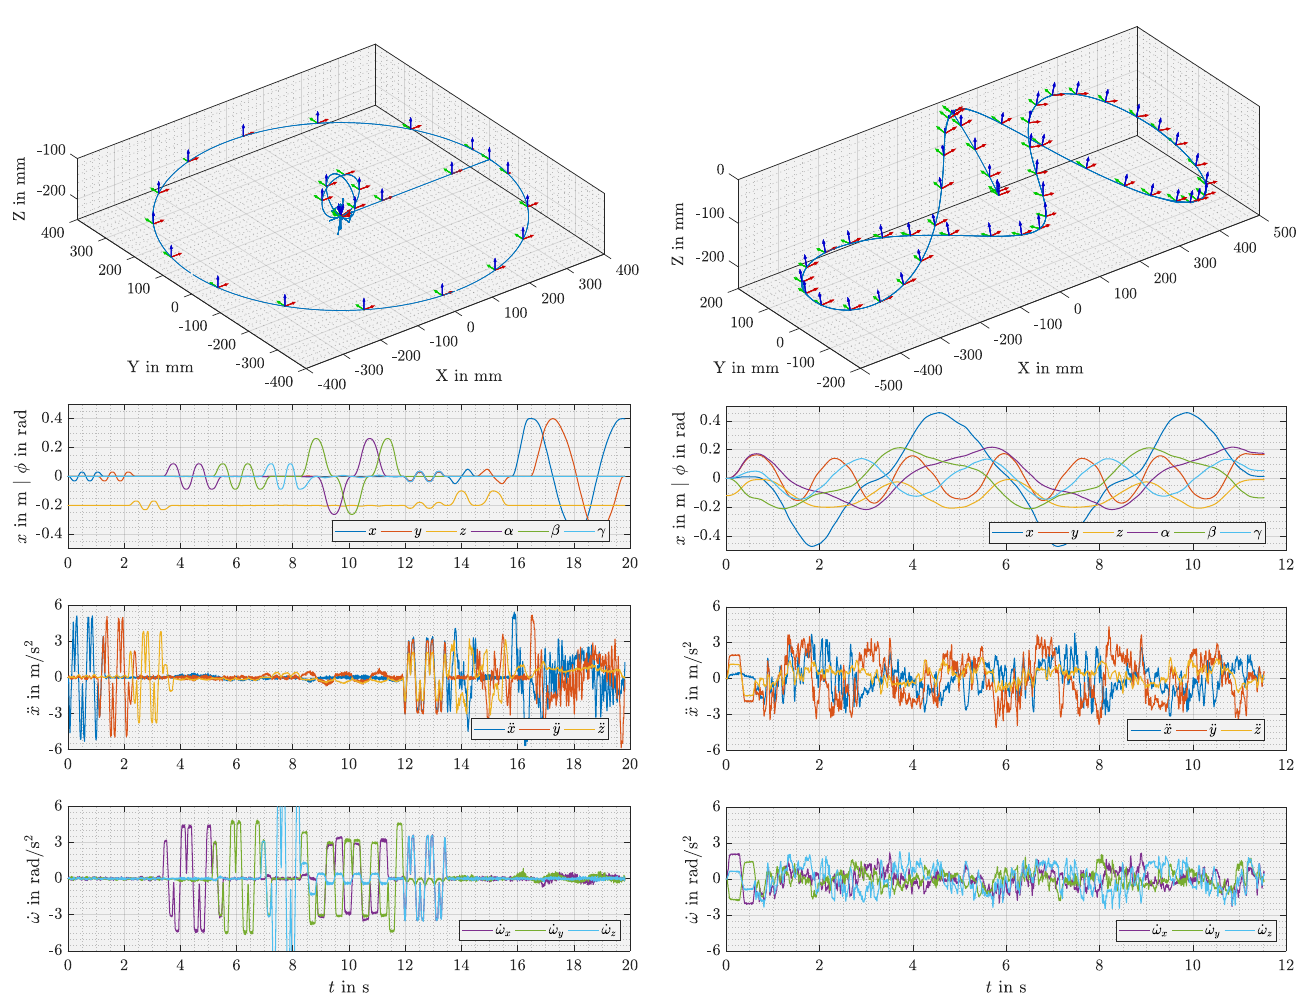
Figure 5. Trajectories and corresponding measured accelerations for dynamic parameter identification; left : manually designed excitation trajectory with independent excitation of the Cartesian directions (D9M), right : excitation trajectory resulting from N-optimal 3rd order periodic Fourier series